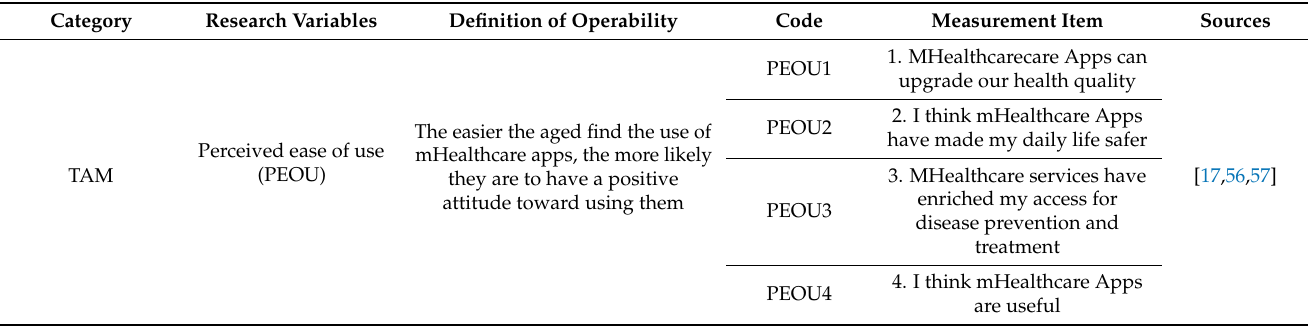
Table 1. Variables and indicators of the research.